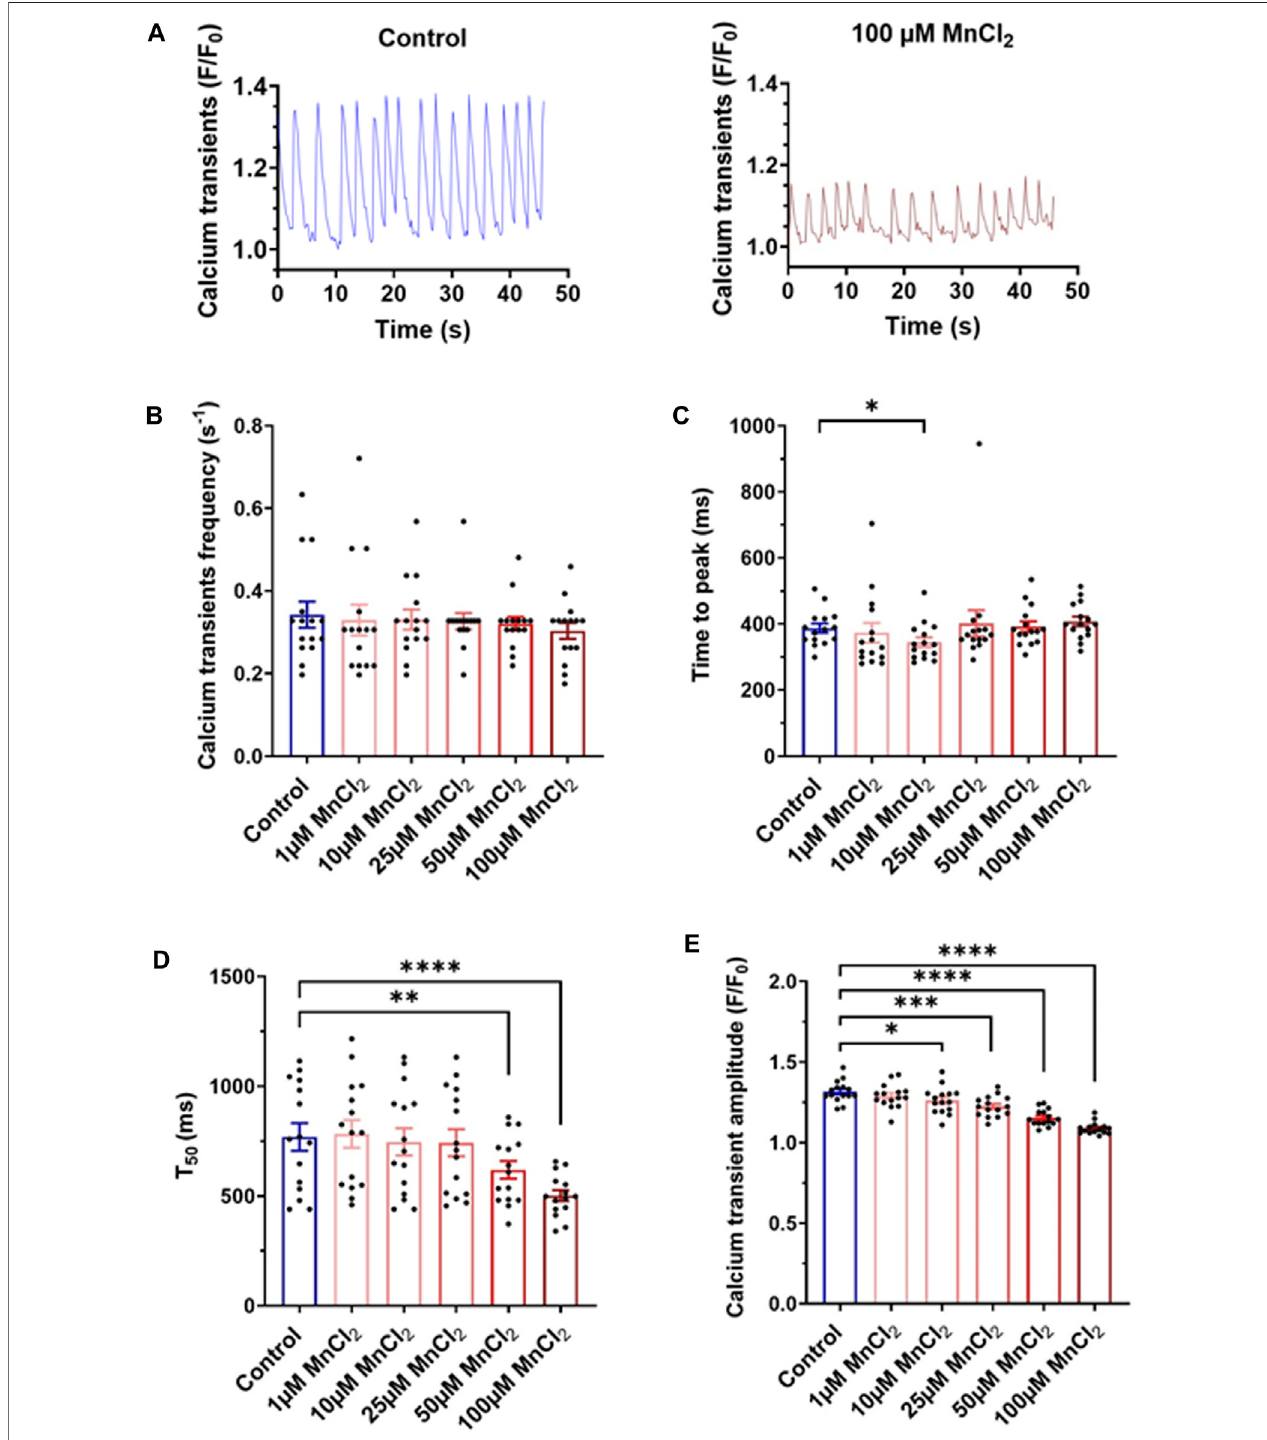
FIGURE3| VariationofcalciumtransientsinducedbyMnCl 2 inHL-1 (A) RepresentativeplotsofcalciumtransientsinHL-1observedoncontrolsolution(left)andat 100 µM of MnCl 2 (right). (B) Frequency (C) time of peak (D) time at 50% of the relaxation (T 50 ) and (E) amplitude of calcium transients depending on different conditions ( N = 3, n = 15). * p < 0.05, ** p < 0.01.